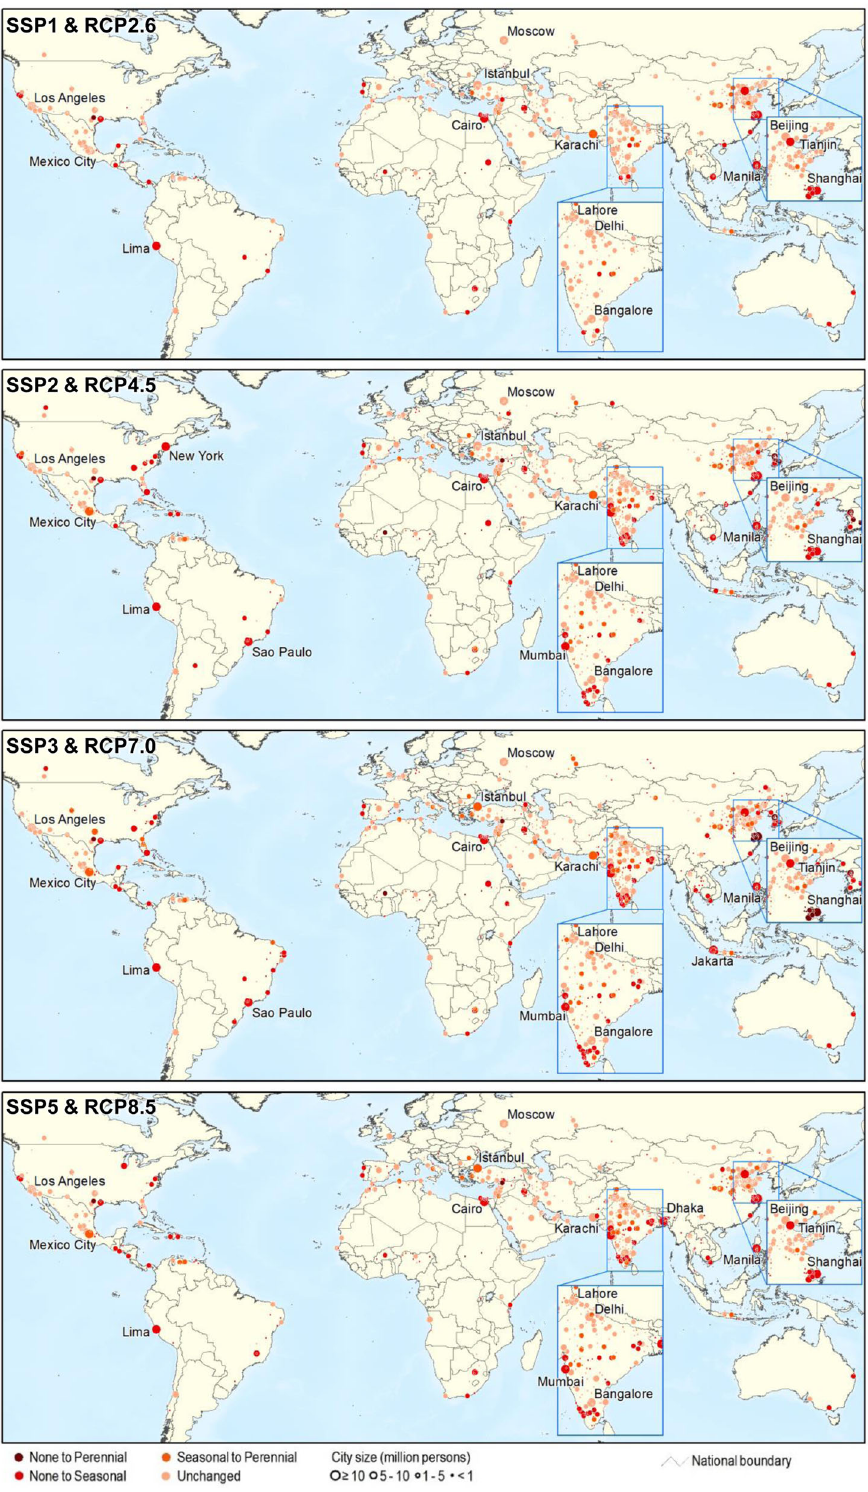
Fig. 3 Changes in large cities subject to water scarcity from 2016 to 2050 under the four socio-economic and climate change scenarios. Only the water-scarce cities are listed. Cities with a population >10 million in 2016 are